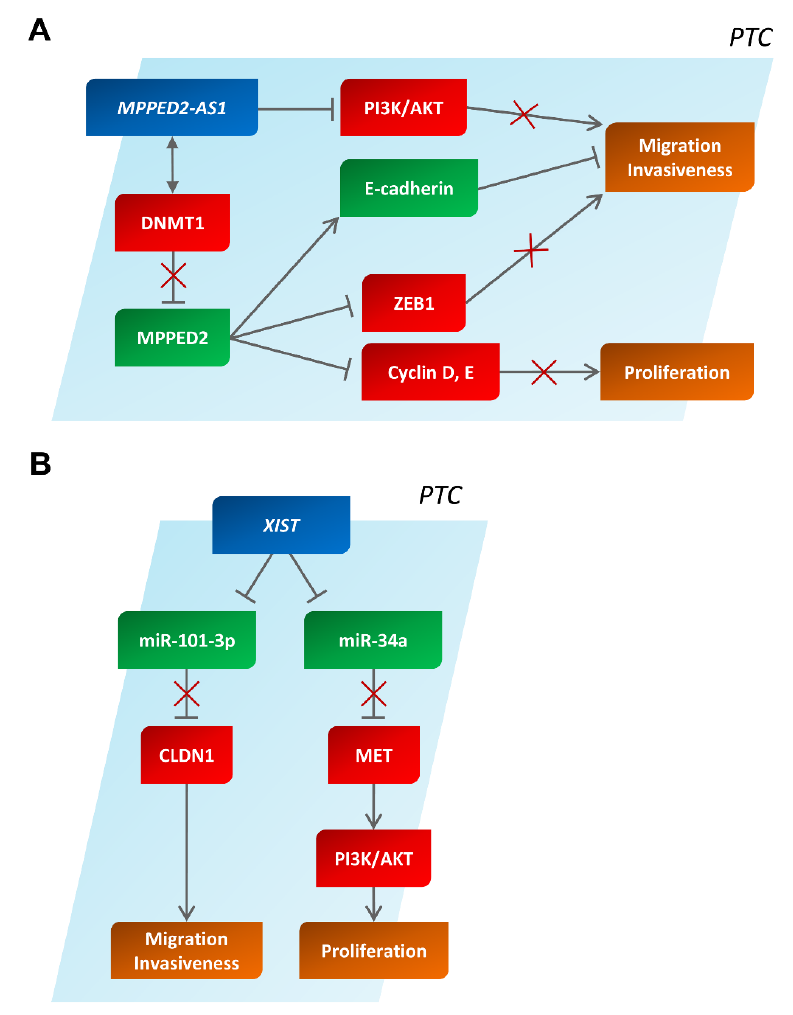
Figure 3. The involvement of MPPED2-AS1 and XIST in human papillary thyroid carcinoma. Schematic representation of several interactions explaining the role of MPPED2-AS1 ( A ) and XIST ( B ) in human papillary thyroid carcinomas. In red and in green, partners with an oncogenic or anti-oncogenic behavior are reported, respectively. PTC, papillary thyroid carcinoma.